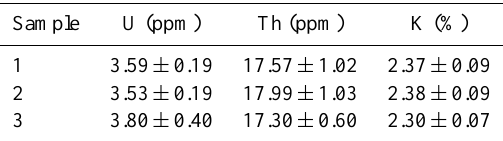
Table 2. Radionuclide contents of bulk sediment samples from three different core segments. All analysis was done by high-resolution gamma-ray spectrometry with samples 1 and 2 (core from 2011) measured at the Cologne lab., and sample 3 (core from 2009) anal- ysed at the VKTA lab., Dresden. All errors represent the 1- σ level. For dose rate calculation the mean values were